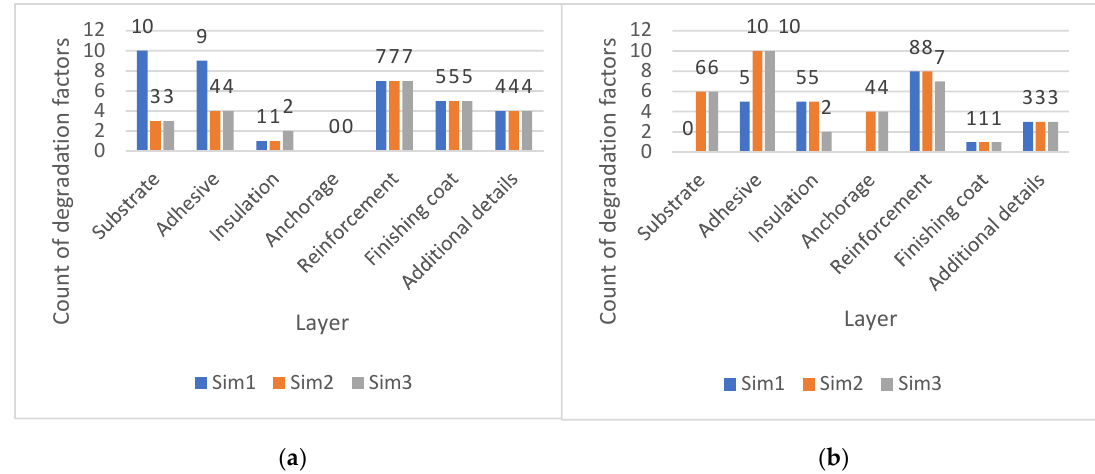
Figure 12 . Distribution of the high- and medium-risk category degradation factors by layer and by latency period of ( a ) less than two years and ( b ) equal to or more than two years.